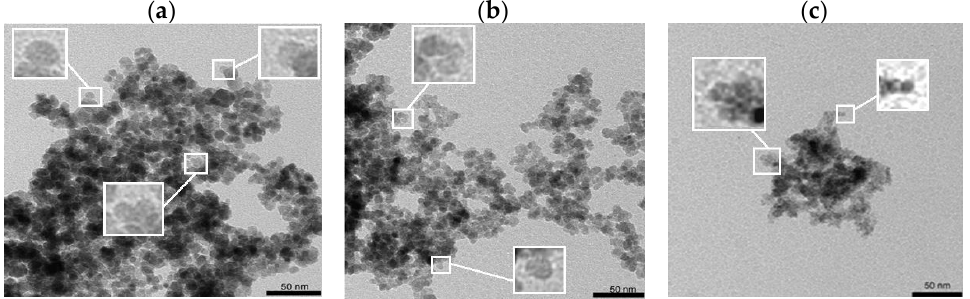
Figure 3. TEM images of ( a ) sample 1 with 1 mL post-leaching solution, ( b ) sample 2 with 2.5 mL post-leaching solution, and ( c ) sample 3 with 5 mL post-leaching solution. post-leaching solution, and ( c ) sample 3 with 5 mL post-leaching